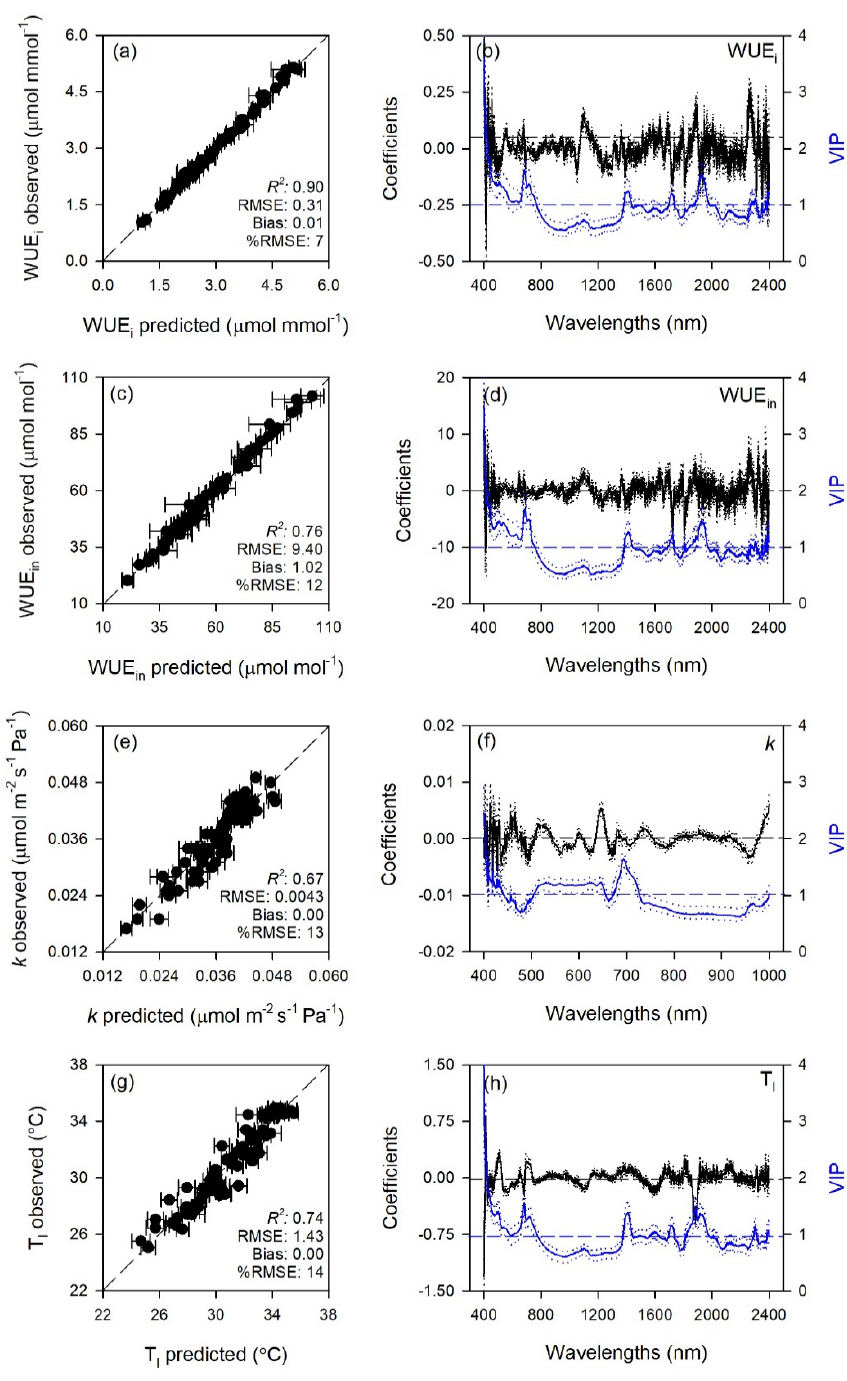
Figure 2. ( a , c , e , g ) Observed versus partial least squares regression (PLSR)-predicted values of intrinsic water use efficiency (WUE i ), instantaneous water use efficiency (WUE in ), CO 2 assimilation rate:intercellular CO 2 concentration ratio ( k ) and temperature of adaxial leaf surface (T l ) in sage; error bars for predicted values represent the standard deviations generated from 500 simulated models; dashed line is 1:1 relationship; model goodness-of-fit ( R 2 ), root mean square error (RMSE), bias and %RMSE for validation data generated using 80% of the data for calibration and 20% for validation are reported. ( b , d , f , h ) Mean (solid), 5th and 95th percentile (dotted) of standardized coefficients (black), and variable importance for projection values (VIP, blue) by wavelengths for PLSR-models predicting WUE i , WUE in , k , and T l in sage.